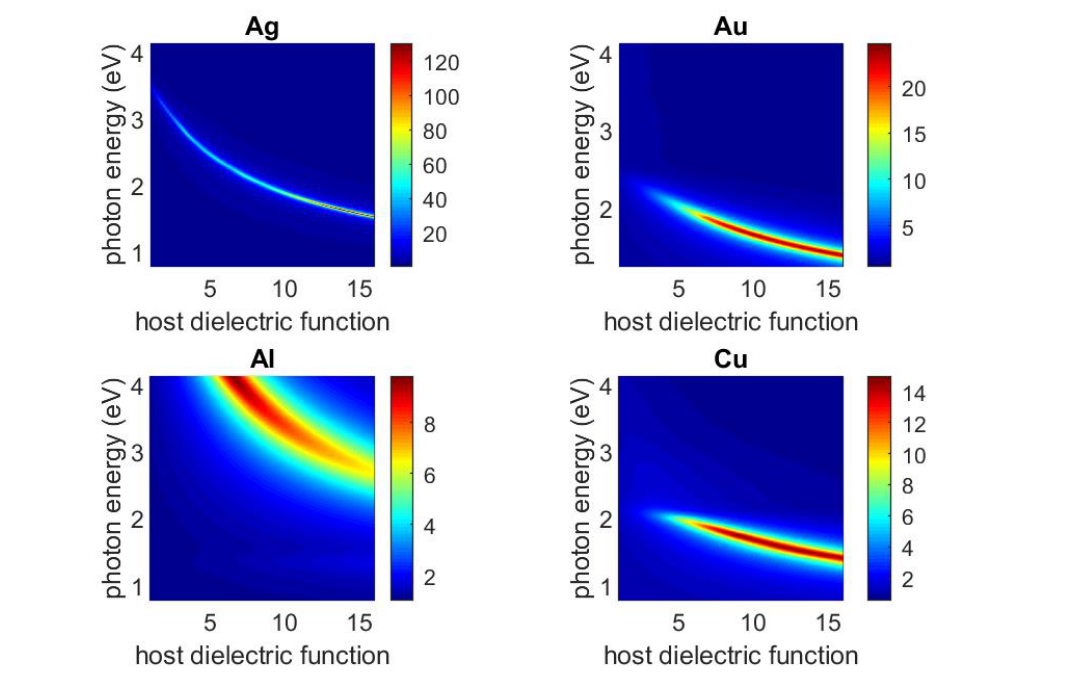
(cid:0) (cid:1) 4 π(cid:101) 0 a 3 , Equation (1) for Ag, Au, Al and